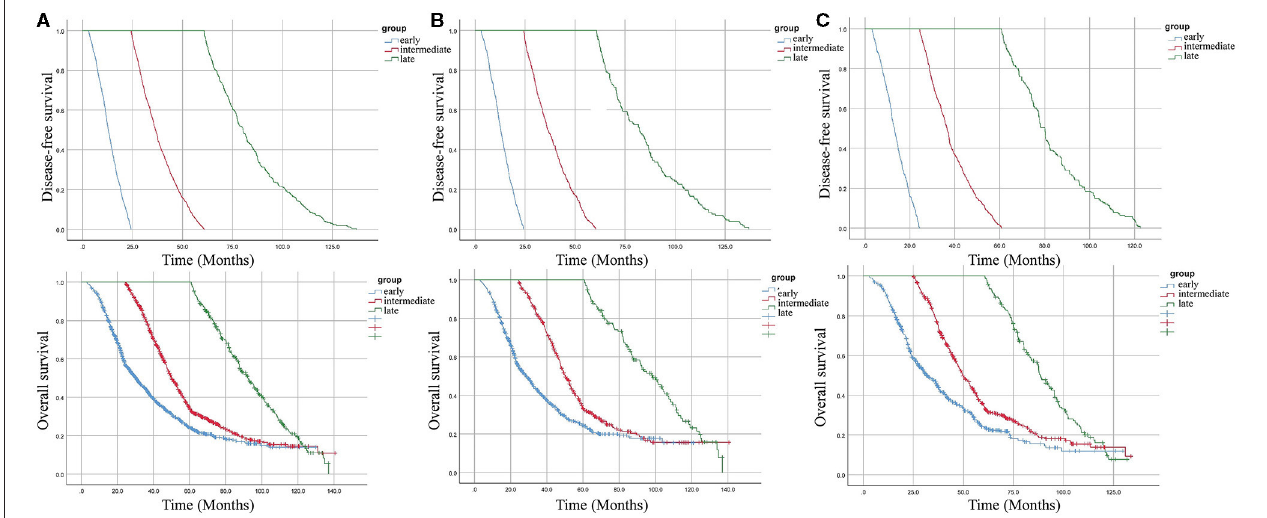
FIGURE 1 | Kaplan–Meier curves for disease-free survival (DFS) and overall survival (OS) according to the time taken for recurrence. (A) overall cohort. (B) patients with colon cancer. (C) patients with rectal cancer.